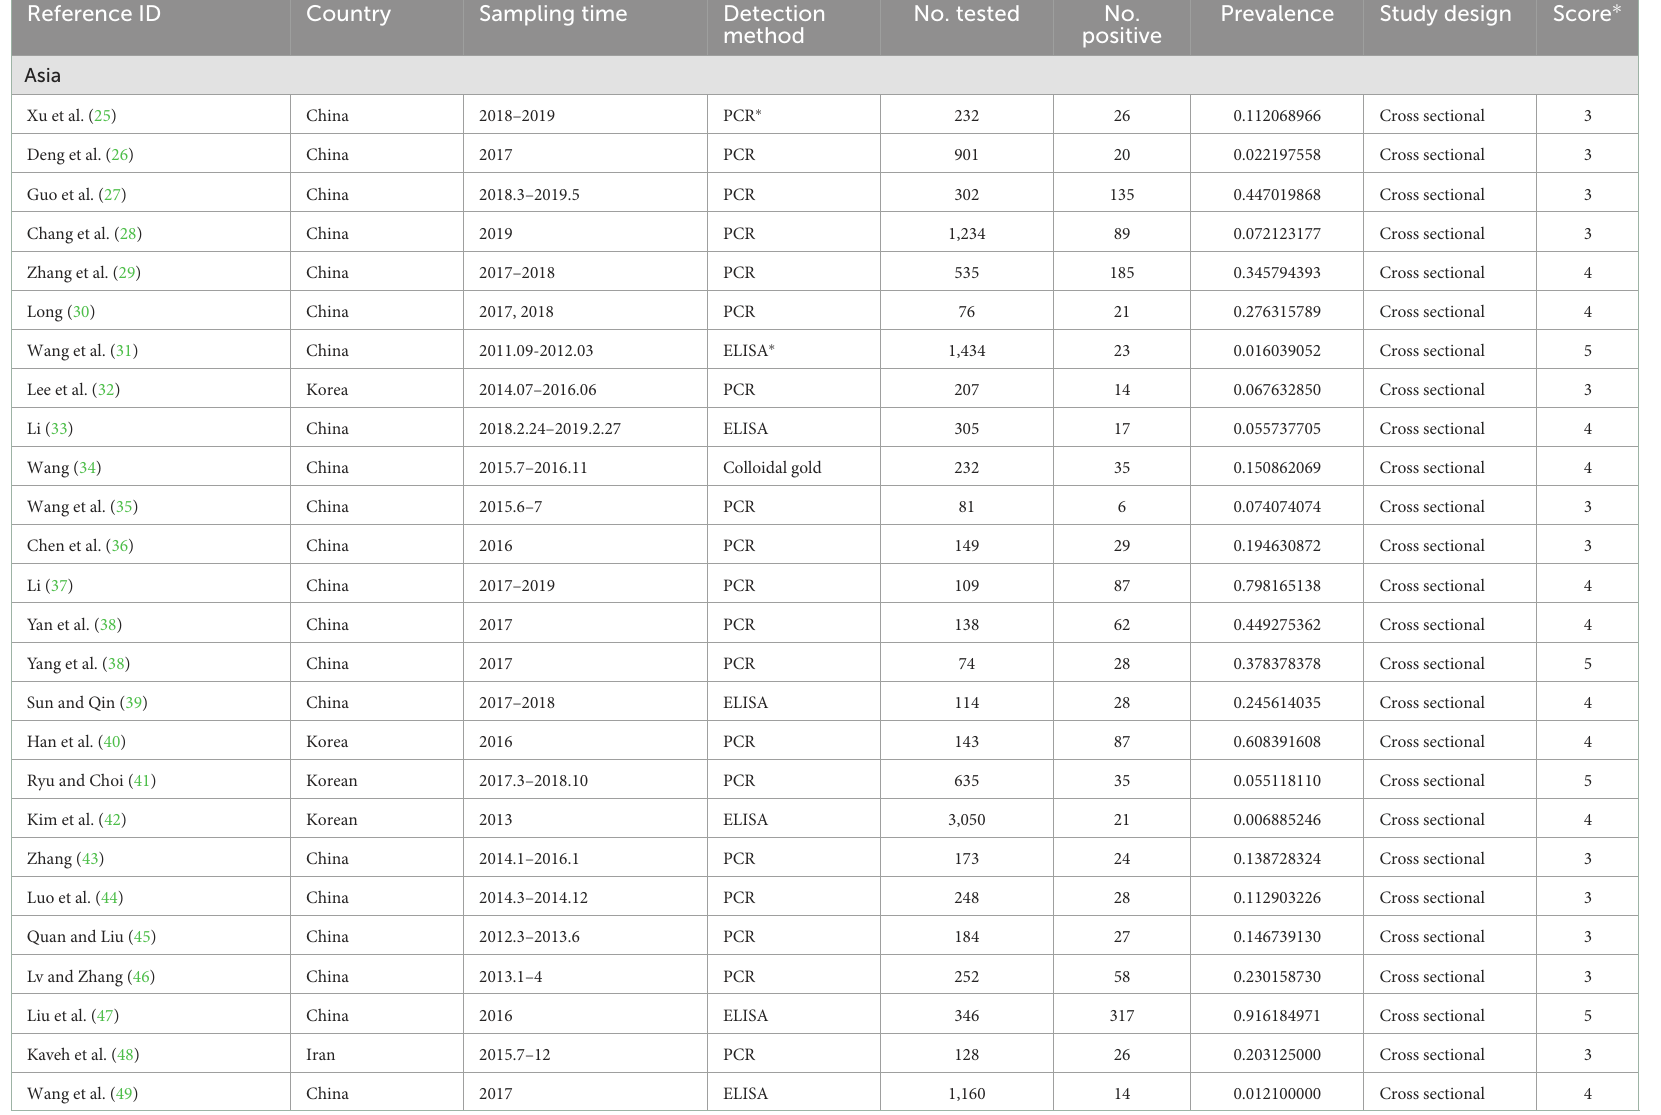
TABLE 1 Included studies of Bovine viral diarrhea virus infection of cattle in the word. Reference